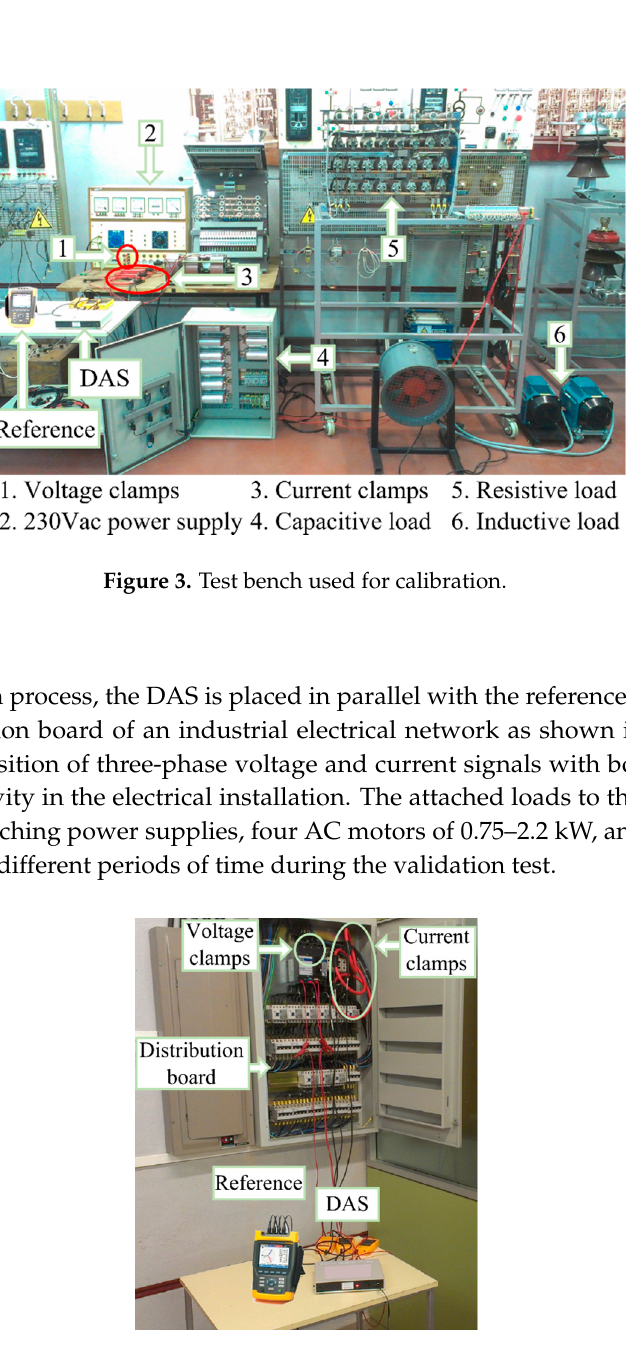
Figure 5. Data acquisition system (DAS) locations at the hospital.